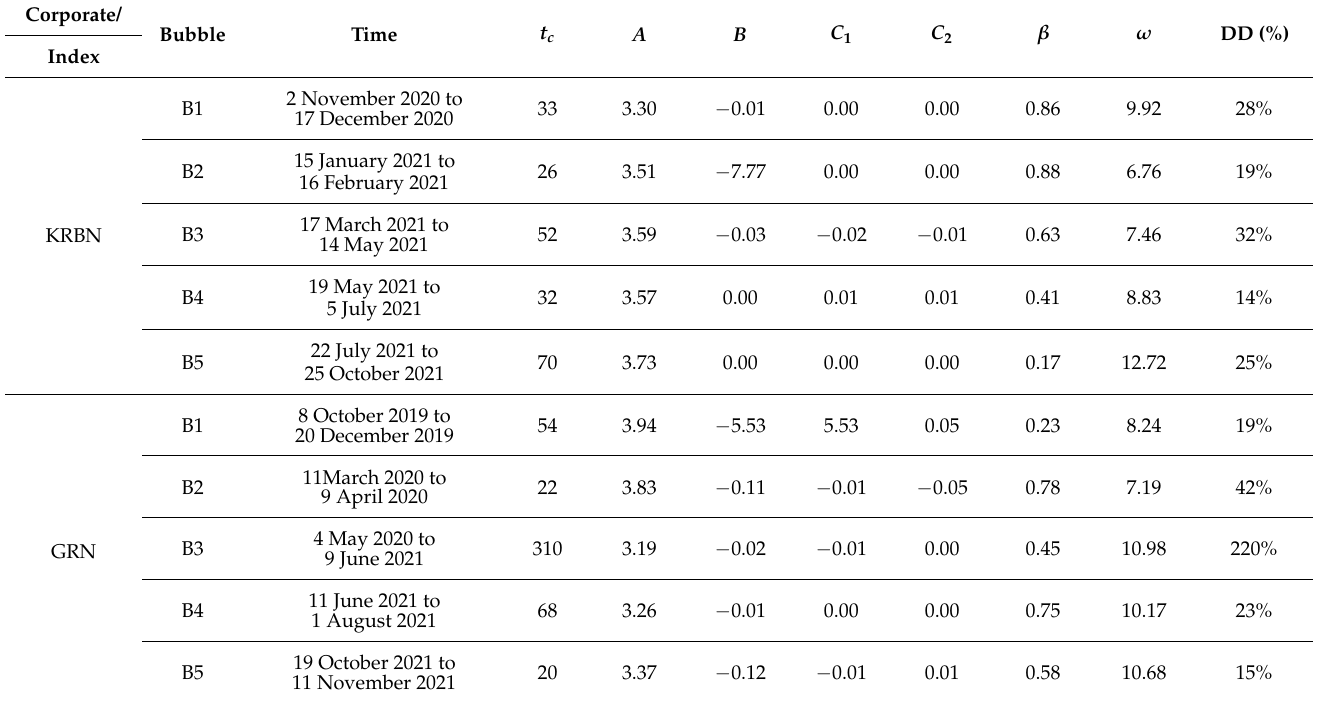
Table 2. Coefficients of the LPPL parameters having a drawdown of